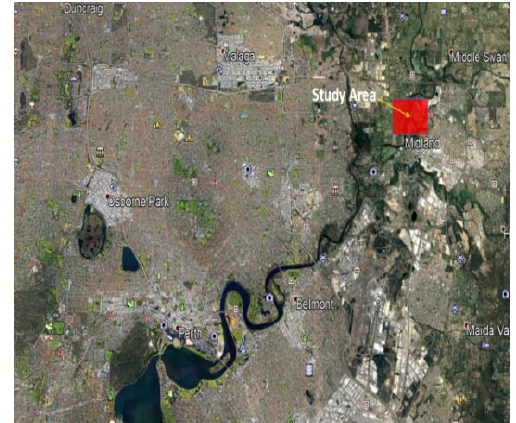
Figure 1. Map of study area (image taken from Google